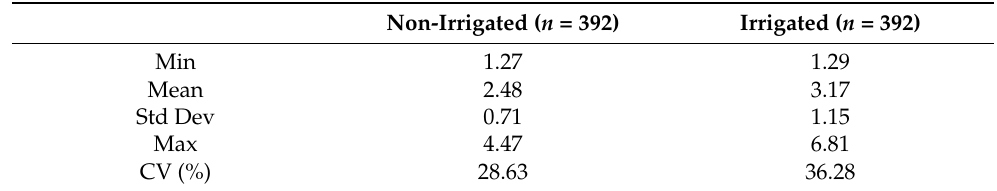
Table 2. Summary statistics for grain yield of sorghum.